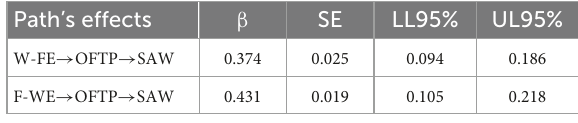
TABLE 3 Direct effect. TABLE 4 Indirect